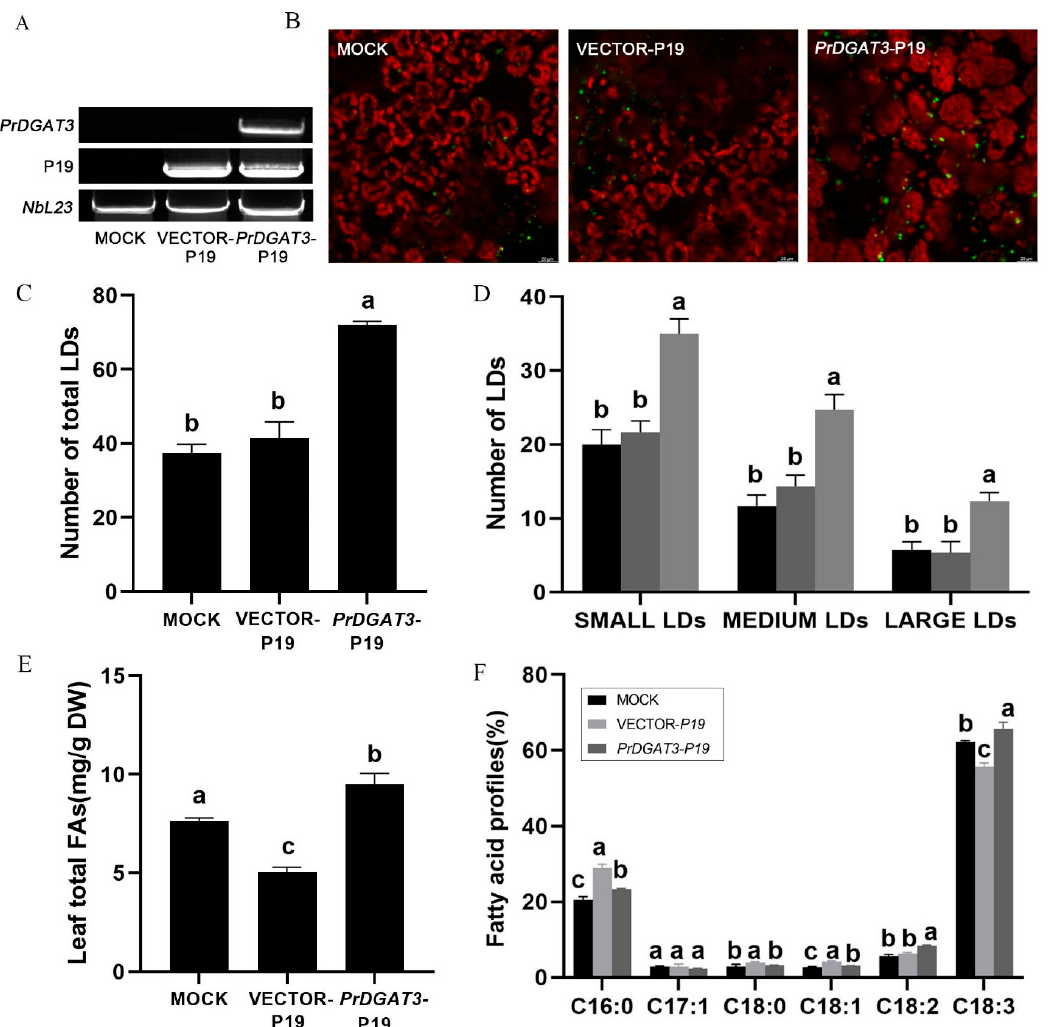
Figure 4. Functional verification of PrDGAT3 in transformed N. benthamiana leaf tissue. ( A ) RT-PCR analysis of PrDGAT3 expressed in tobacco leaf tissue. ( B ) Representative confocal images of LDs in N. benthamiana leaf tissue. Green color shows LDs and red color shows chloroplasts. Images are shown as 232.92 × 232.92 µm 2 field of the leaf tissue. Bars = 20 µm. ( C ) Number of total LDs per image area in mock, P19 -transformed, and PrDGAT3 -transformed N. benthamiana leaf tissue. ( D ) Number of LDs in different size categories per image area. Small LDs: Nile red-stained lipid area < 3 µm 2 ; medium LDs: 3–6 µm 2 ; large LDs: 6–10 µm 2 . ( E ) Total oil content in tobacco leaves (% dry weight). ( F ) Major fatty acid profiles in TAG. Values are mean ± SD ( n = 3). Different letters indicate